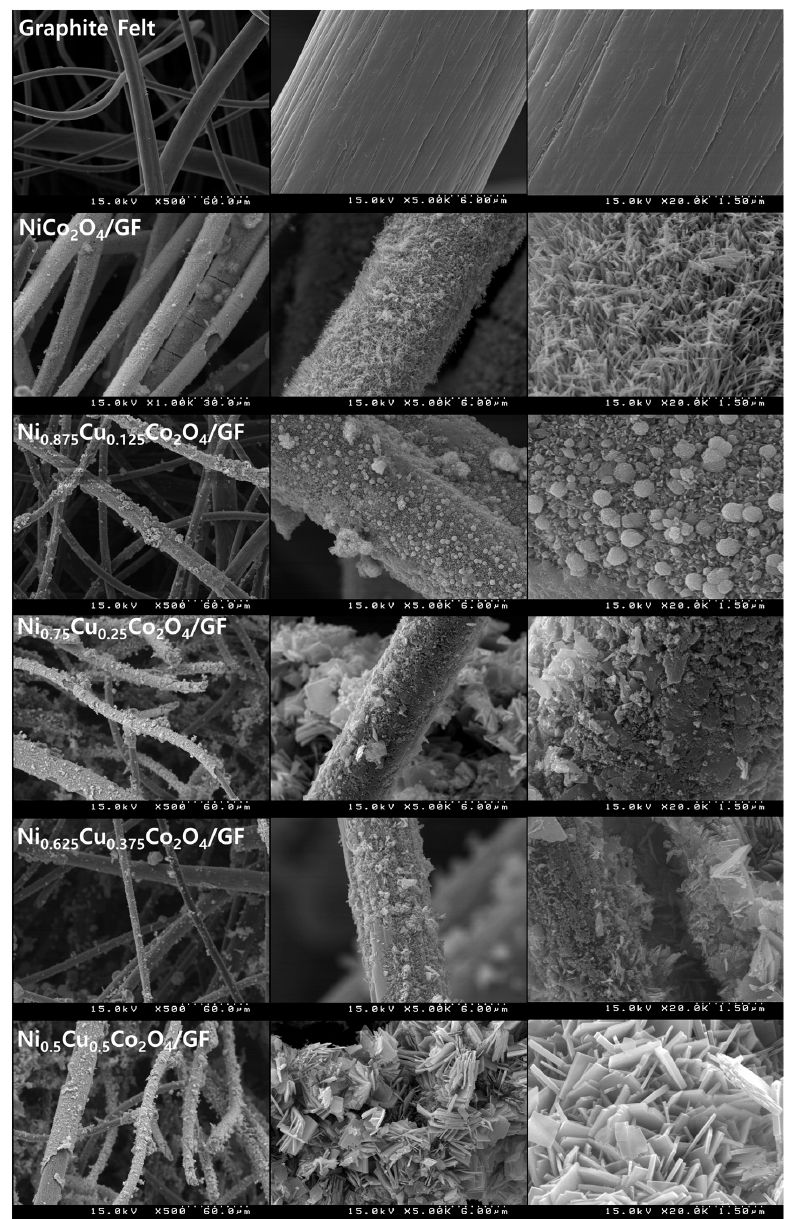
Figure 2. SEM images for the surfaces of Ni 1 − x Cu x Co 2 O 4 /GF electrodes.